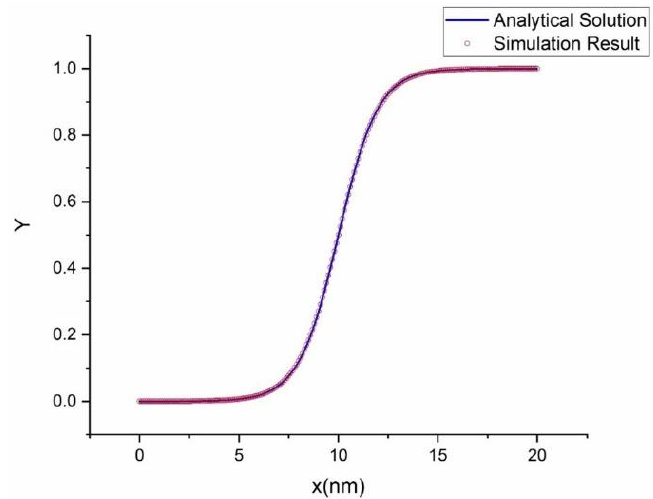
Figure 9. Comparison of numerical result with the analytical result. Our finite element code reproduces matches with the analytical solution.